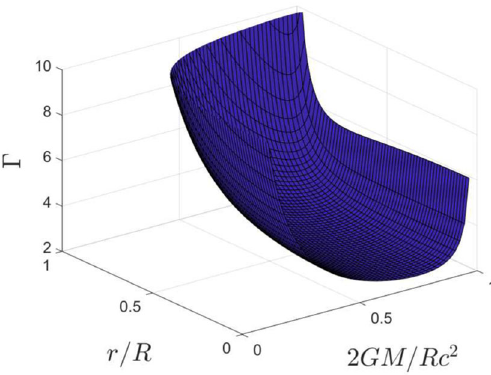
Fig. 6 The adiabatic index (cid:13) with respect to compactness and distance from the